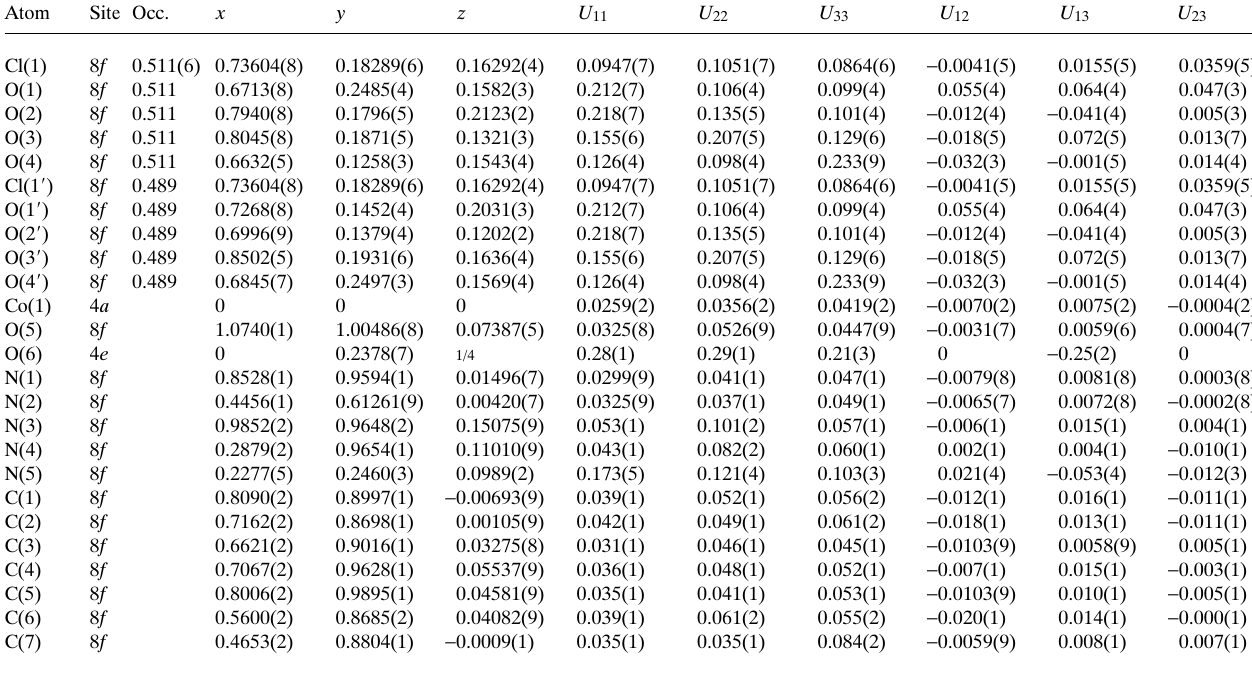
Table 3. Atomic coordinates and displacement parameters (in Å 2 ) .